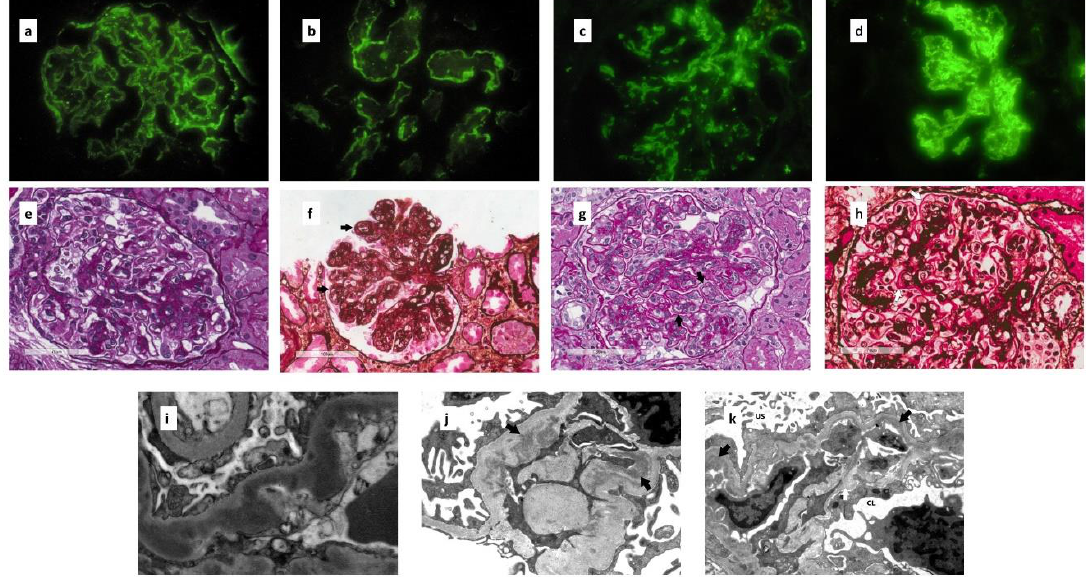
Figure 4. ( a ) Ribbon like pattern of C3 deposition along glomerular basement membrane in a patient with DDD (×400). ( b ) Linear C3 deposition along tubular basement membrane in DDD (×400). ( c ) Granular mesangial C3 deposits in a patient with a mesangial proliferative C3 GN (×400). ( d ) Coarsely granular mesangial and glomerular capillary wall C3 deposits in a patient with membranoproliferative pattern of C3 GN (×400). ( e ) Glomerulus with segmental mesangial proliferation in a patient with C3 GN (PAS). ( f ) Glomerulus with global membranoproliferative pattern of injury in a patient with C3 GN. Several aspects of glomerular basement membrane double contours (black arrows) are present (Jones silver stain). ( g ) Glomerulus with thickened strongly PAS positive glomerular basement membranes with several double contours (black arrows) (PAS) in a patient with DDD. ( h ) Silver negative glomerular basement membrane in a patient with DDD (white arrows). Glomerular basement membranes appear eosinophilic and refractile (Jones silver stain). ( i ) Highly osmiophilic electron dense deposits permeating lamina densa in a patient with DDD (TEM, ×8900). ( j ) Mesangial electron dense deposits (black arrows) in a patient with mesangial proliferative C3 GN (TEM, ×11000). ( k ) Subendothelial electron dense deposits (black arrows) with newly formed lamina densa (i.e., double contours) and cellular interposition (white arrow) in a patient with membranoproliferative patter of C3 GN (US: urinary space, CL: capillary lumen) (TEM, ×8900).